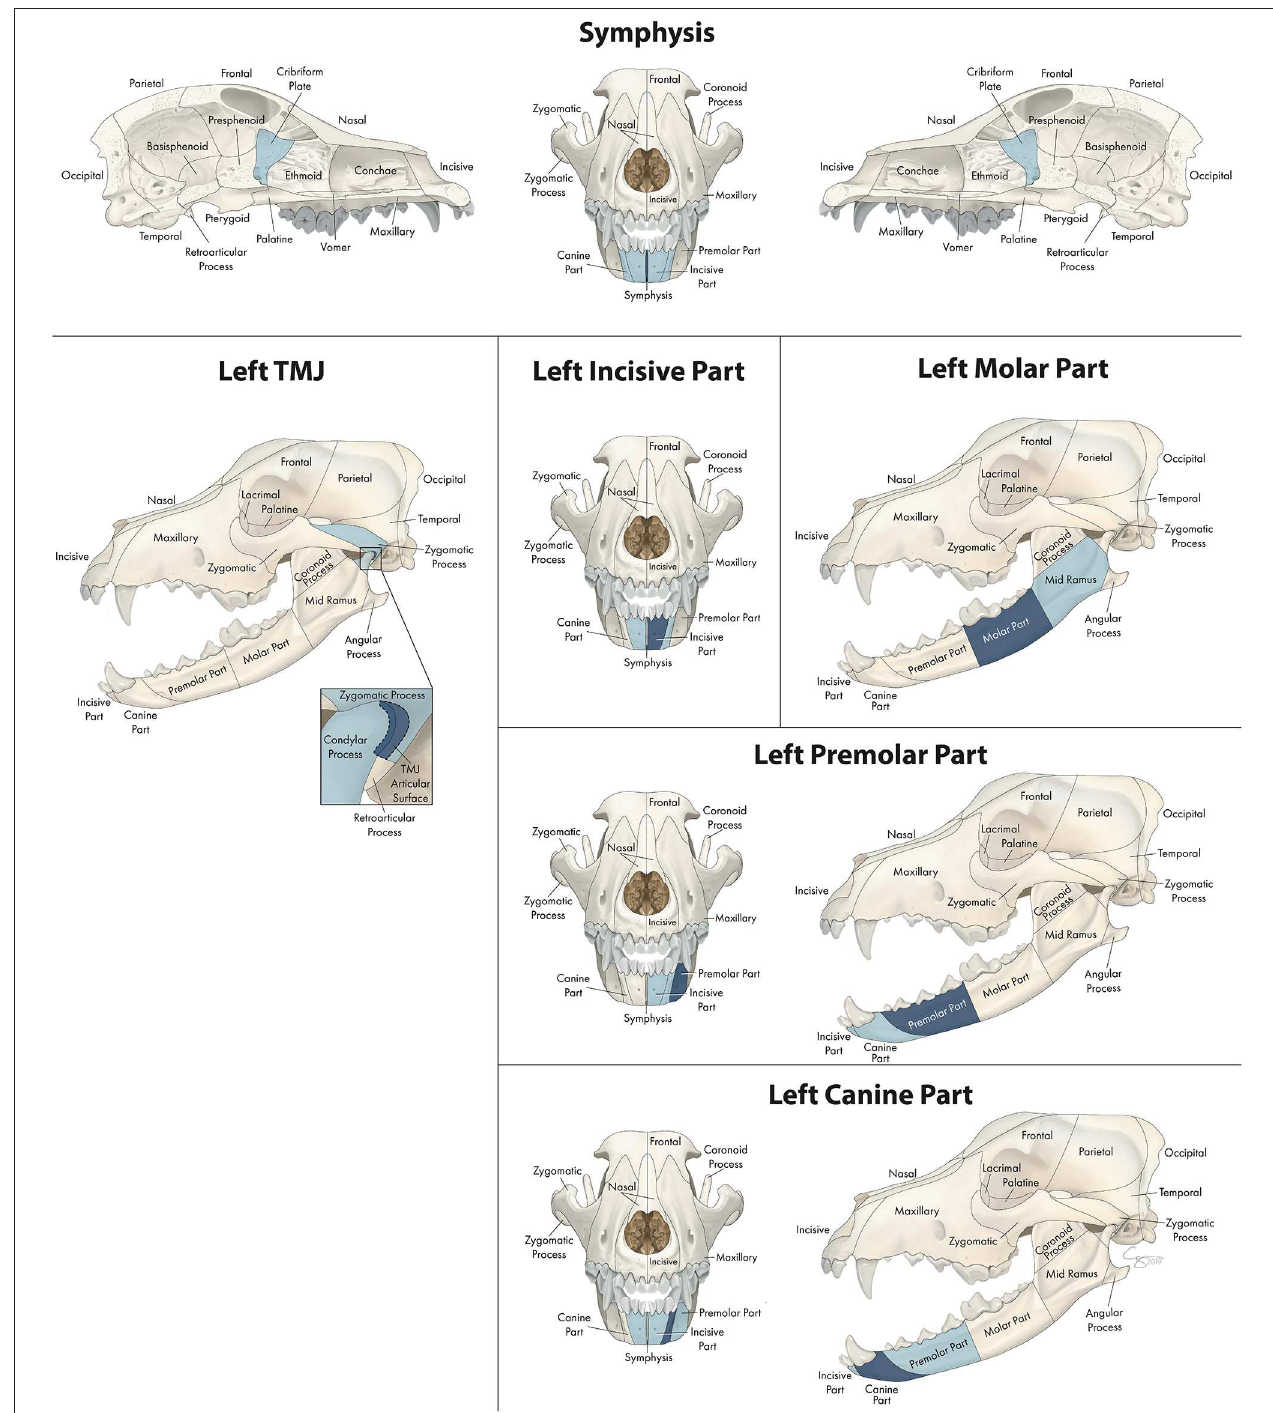
FIGURE 1 | Significant bones or regions fractured concurrently with the various regions of the mandible. Although the left mandible is shown, when the right mandible was the region of interest, a mirror image of concurrently fractured locations applied. Only views of the skull that demonstrate a fractured region are shown.